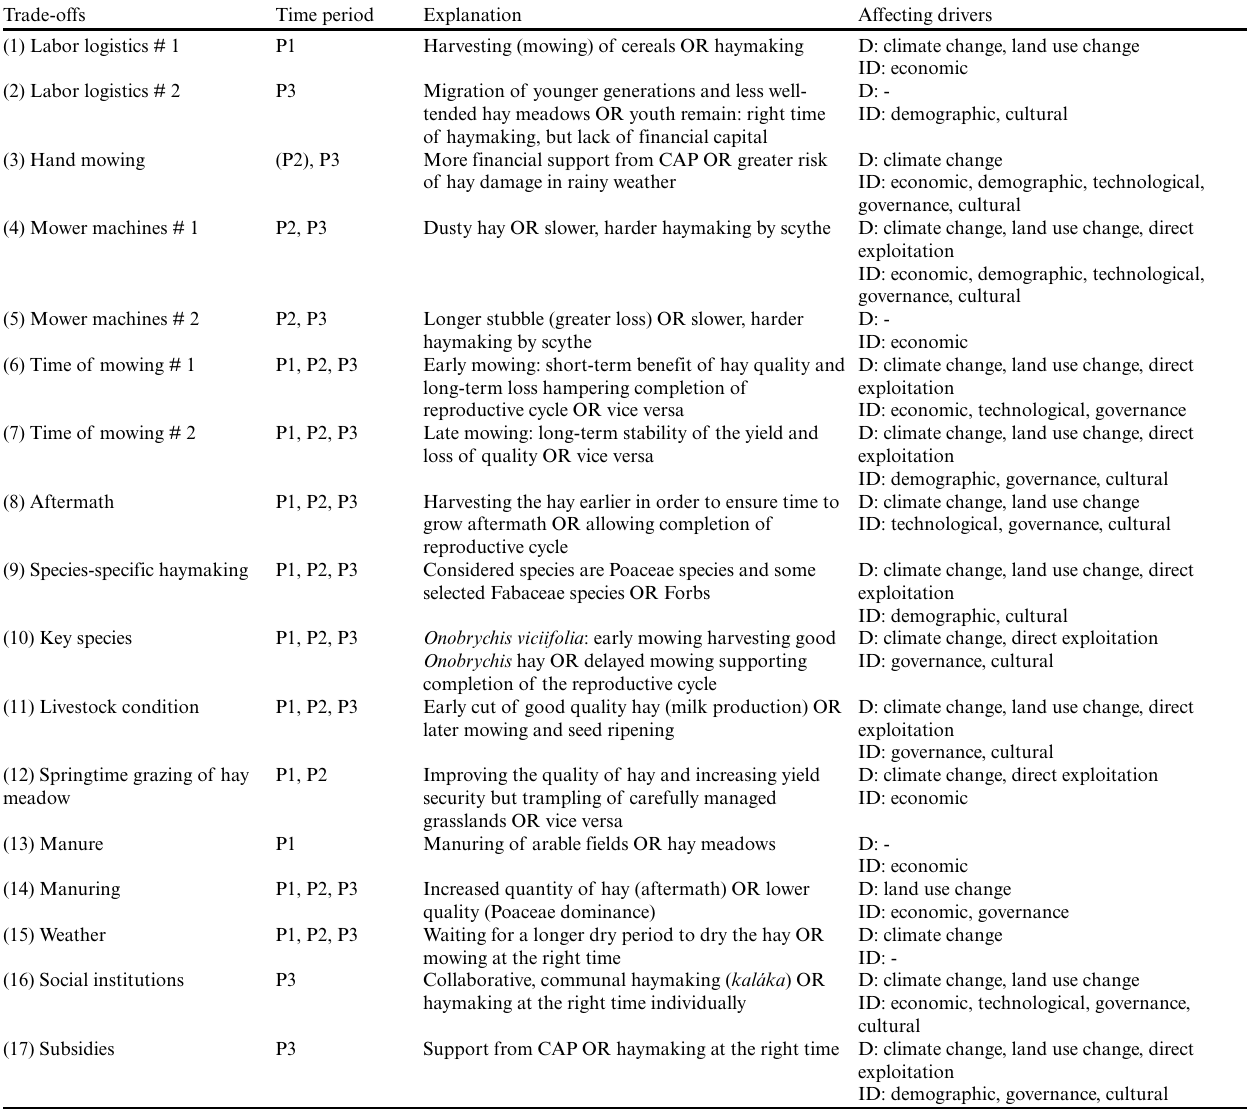
Table 3 . Trade-offs made by local farmers in order to define the appropriate time of mowing. Time periods studied (P1: 1950–1990, P2: 1990–2007, P3: 2007–2020). D: direct drivers, ID: indirect drivers.